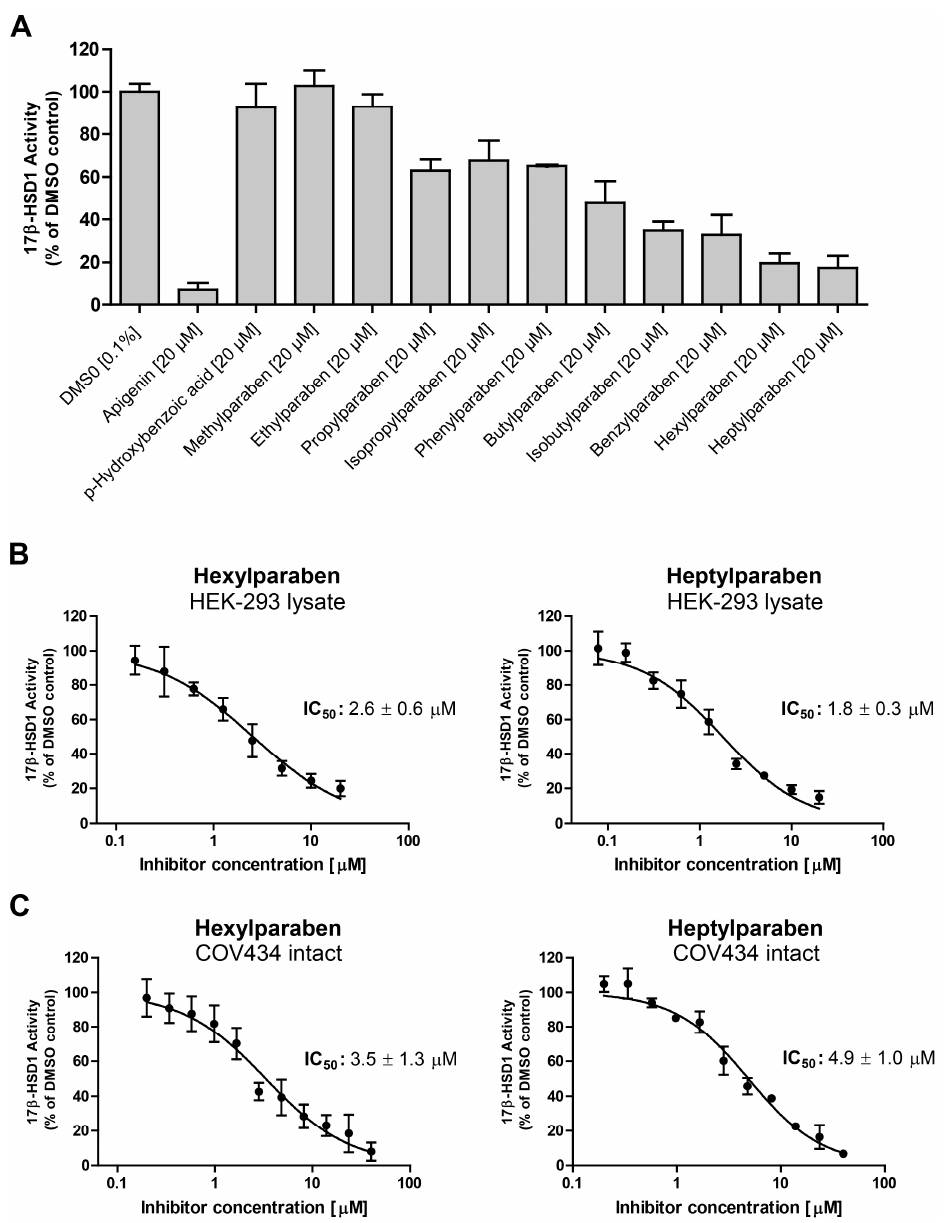
Figure 6. ( A ) Inhibition of 17 β -HSD1 activity by parabens. 17 β -HSD1 activity was measured in lysates of transiently-transfected HEK-293 cells, using DMSO as a negative, and apigenin as a positive, control [20]. Statistical analyses were performed using one-way ANOVA followed by a Dunnett post-hoc test. P -hydroxybenzoic acid, methylparaben, and ethylparaben did not significantly inhibit the activity of 17 β -HSD1. All other tested compounds significantly inhibited 17 β -HSD1 ( p ≤ 0.001). ( B ) Concentration-dependent inhibition of 17 β -HSD1 by hexyl- and heptylparaben. The conversion of estrone to estradiol was measured in lysates of HEK-293 cells transfected with 17 β -HSD1 and ( C ) in intact human COV434 granulosa cells endogenously expressing 17 β -HSD1. Results represent the mean ± SD of three independent experiments.